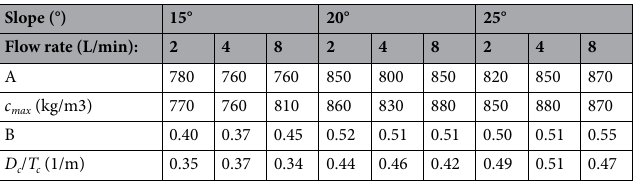
Table 1. Parameters of Eqs. (10) and (11) under experimental slopes and flow rates from Lei et al.